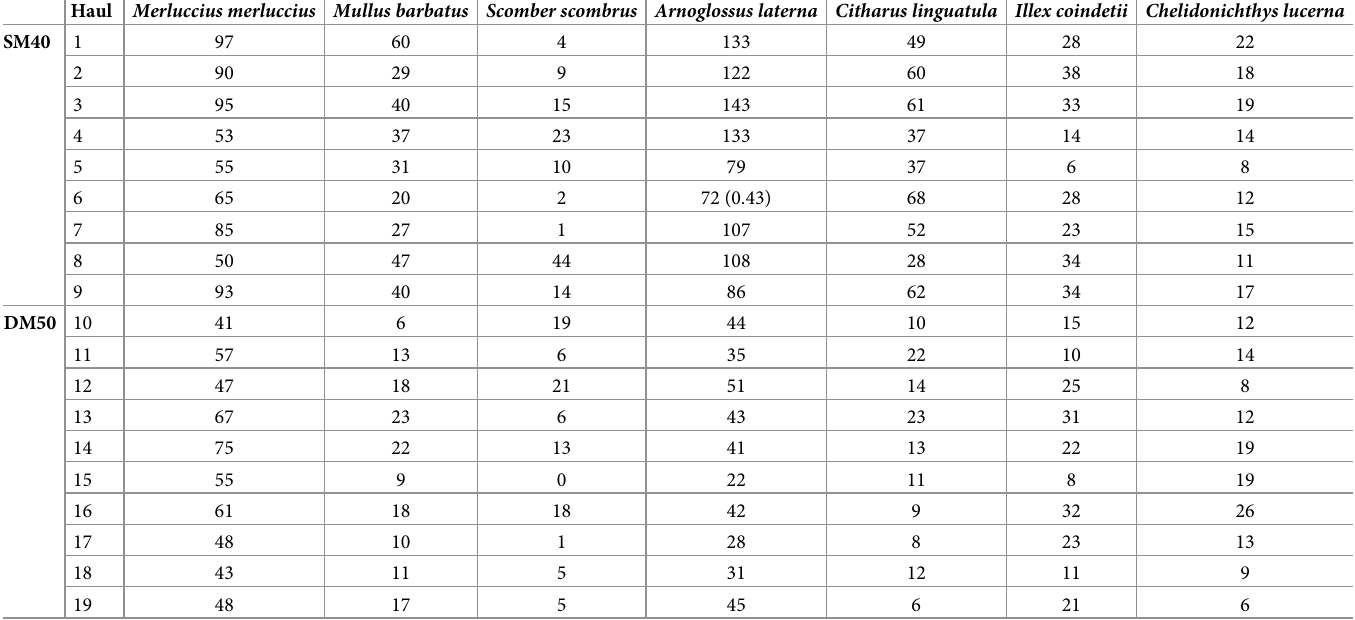
Table 3. Number of individuals of the most abundant commercial species measured in each haul, selected for the catch comparison analyses. No sub-samplings were performed except in one case, where the value of the subsampling coefficient is in brackets. SM40: 40 mm square mesh codend; DM50: 50 mm diamond mesh codend.